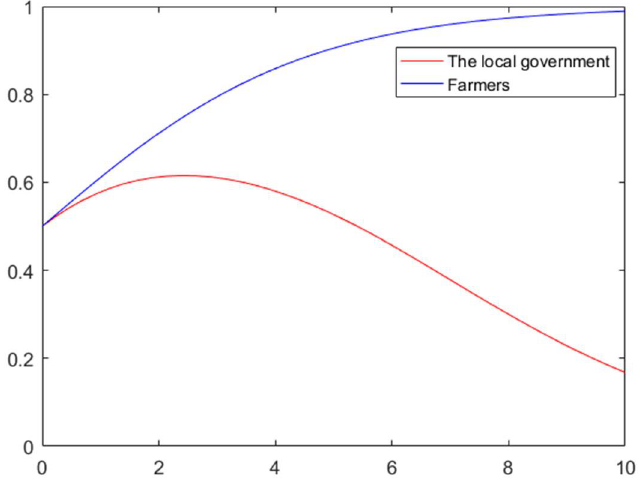
Figure 6. Simulation results at the first stage ( ∆ S 2 = 3.5 ) .